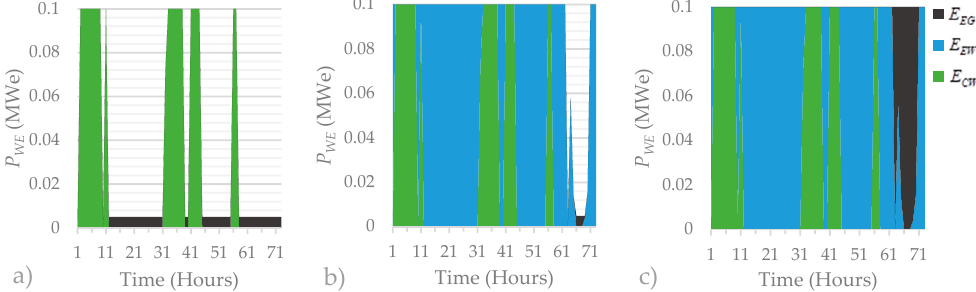
Figure 2. Scenarios of electrolyser operation mode: ( a ) curtailed wind operation, ( b ) available wind operation, and ( c ) full capacity operation.